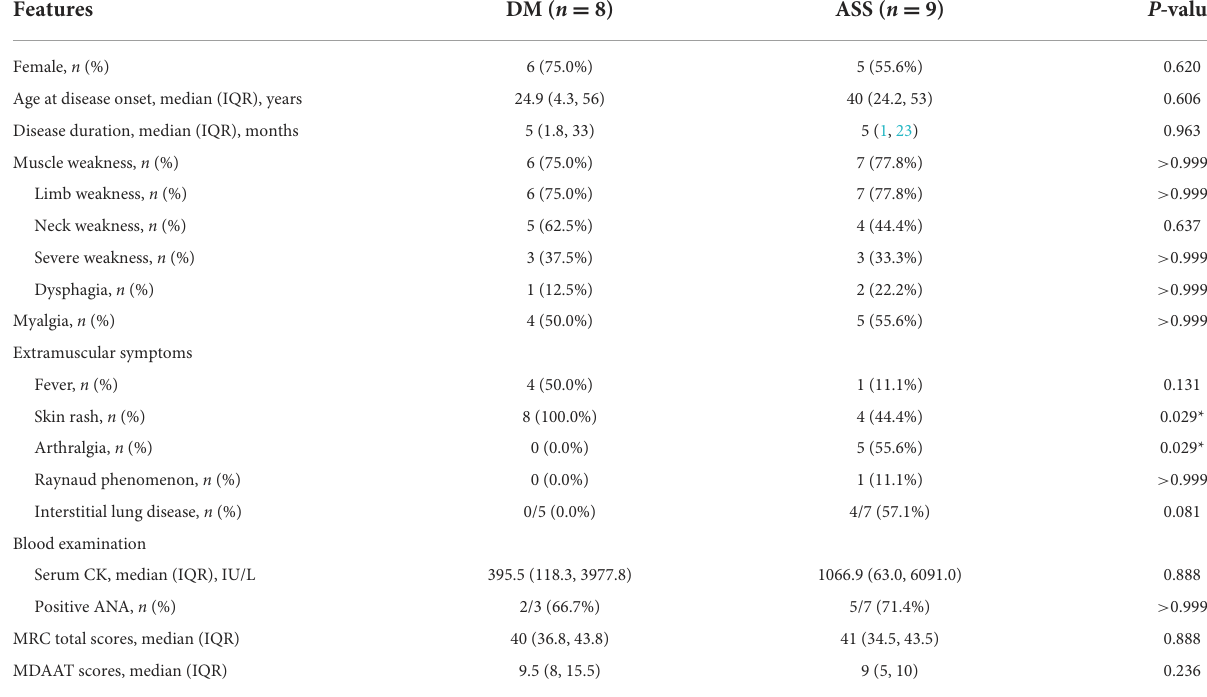
TABLE 1 Demographic and clinical features of patients with DM and